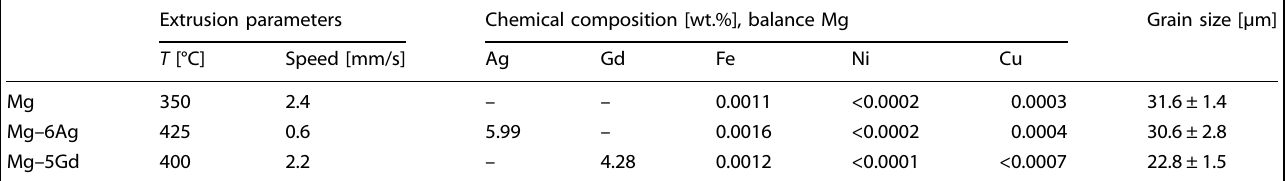
Table 2. Summary of material parameters for Mg, Mg – 6Ag and Mg – 5Gd as used in this